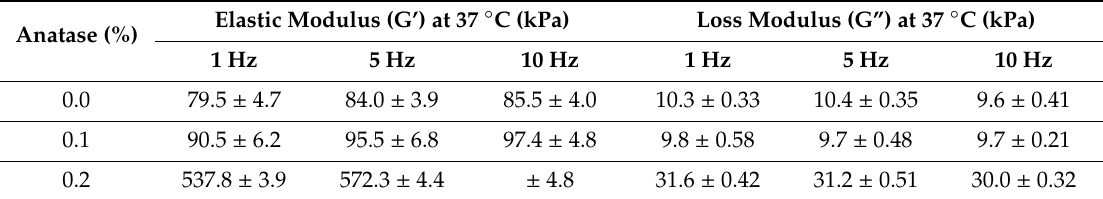
Table 2. Elastic modulus (G’) and loss modulus (G”) at 37 ◦ C of the sca ff olds prepared with di ff erent anatase concentrations.